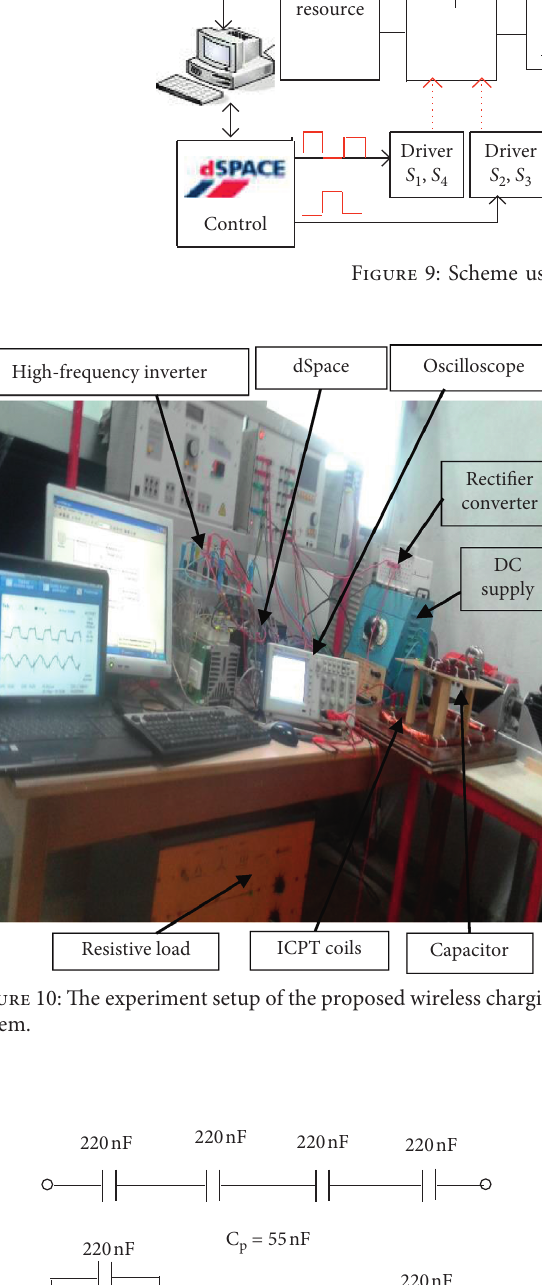
1 and output I 2 currents of the ICPT system at